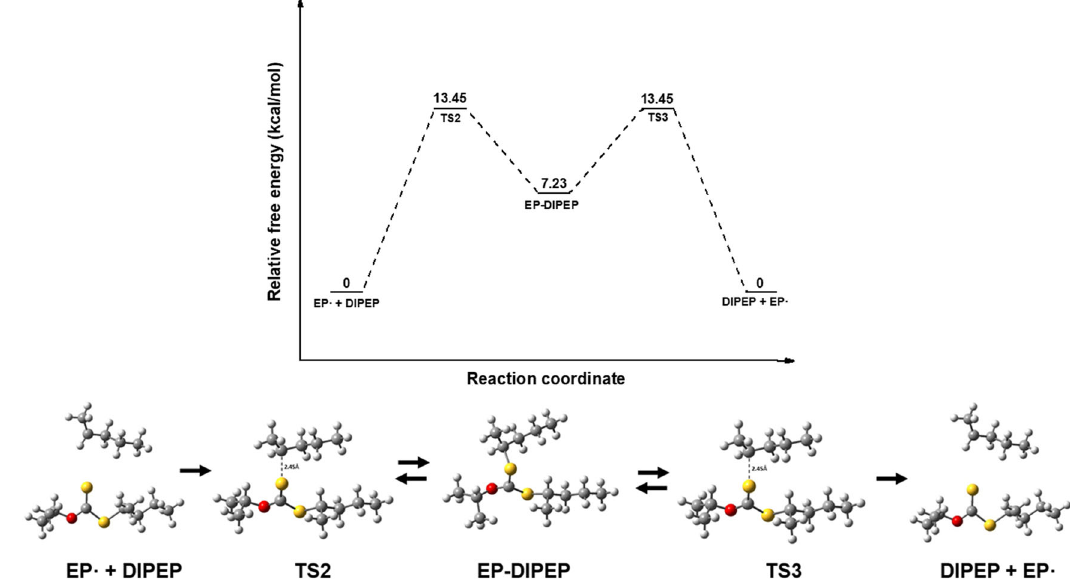
Fig. 11 Energy pro fi les and reaction process. The addition reaction of the second proposed